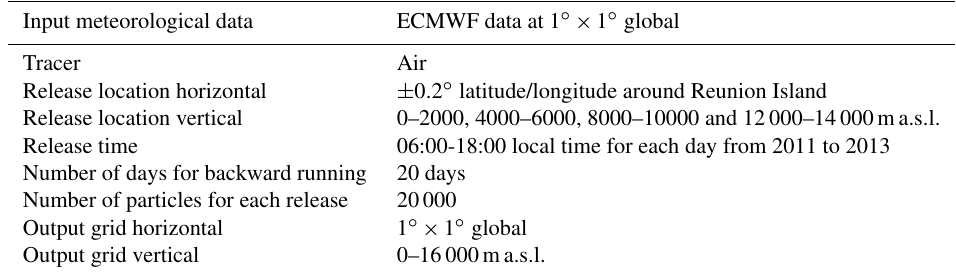
Table A1. The settings of FLEXPART v9.02 backward simulation used in this